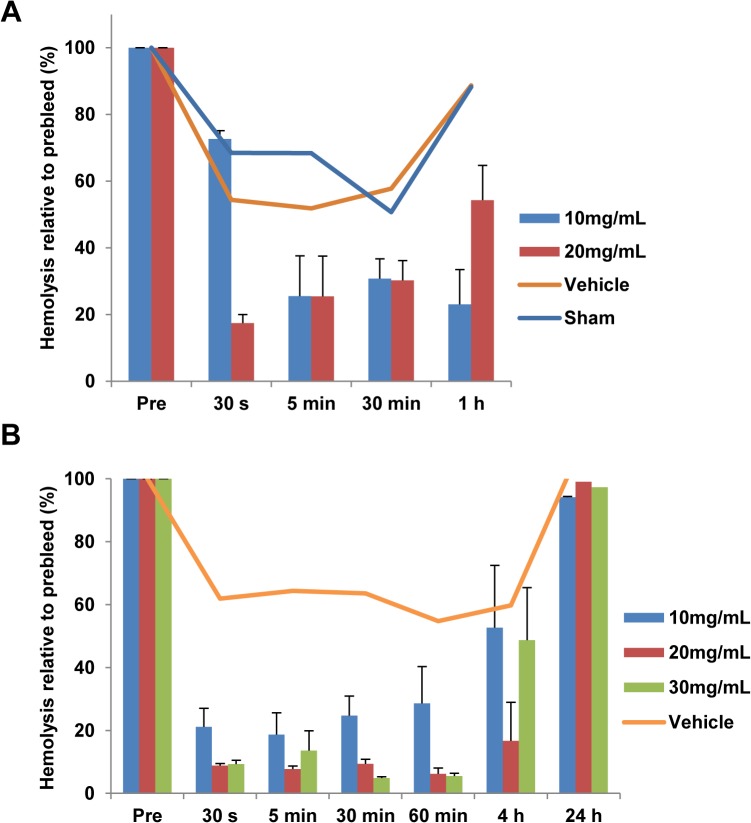
PA-dPEG24 inhibits complement activation in vivo.(A) Rats were IV administered PA-dPEG24 at 10 (n = 2) or 20mg/mL (n = 2) in 0.9% NaCl or received a vehicle control (n = 2) or were sham treated (n = 2). B, Rats were IV administered PA-dPEG24 at 10mg/mL (n = 4), 20mg/mL (n = 4) or 30mg/mL (n = 4) in 10mM Na2HPO4, 0.9% NaCl or received a vehicle control (n = 3). At the indicated time points post-administration, blood was collected and plasma isolated. Plasma was tested in hemolytic assays with human AB erythrocytes. Error bars represent the SEM.